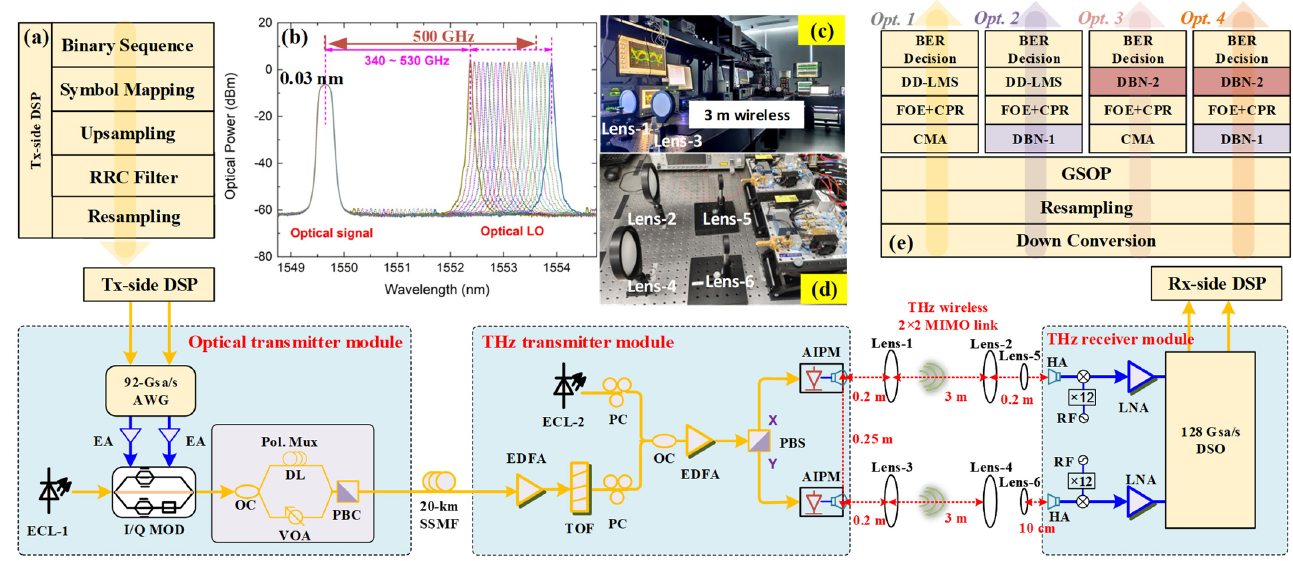
Figure 3. Experimental setup of photonics − aided THz wireless transmission system over 20-km SSMF and 3-m wireless distance with detailed DSP blocks at Tx- and Rx-side, including ( a ) Tx-side DSP block, ( b ) the optical spectra of the optical signal with tunable optical LO after optical coupler (0.03 nm resolution). Insets: ( c ) 3-m 2 × 2 MIMO wireless transmission link. ( d ) Lens position at THz receiver side. ( e ) Rx-side DSP block with three proposed J − DBN optional schemes.